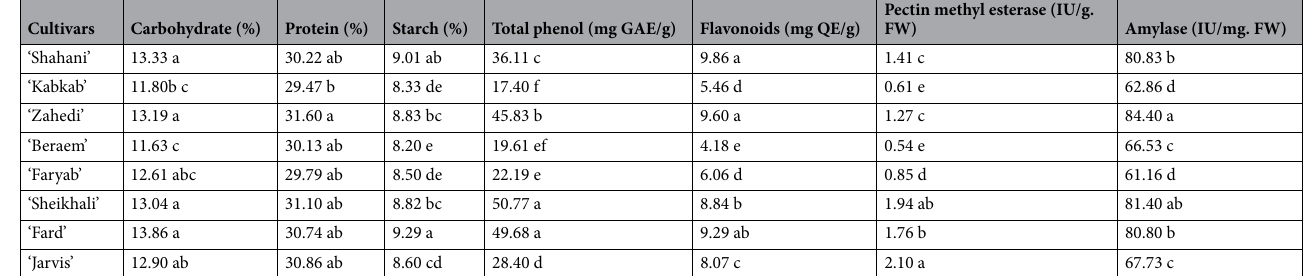
Table 1. The pollen grain ingredients of eight pollinator cultivars of date palm. Different letters within columns indicate significant differences according to Duncan’s multiple range test (p < 0.05).